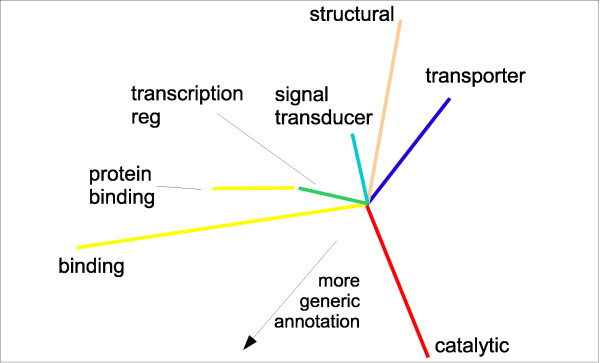
Axes on the Pfam functional map. The main axes of the main clusters from Figure 12 are shown.